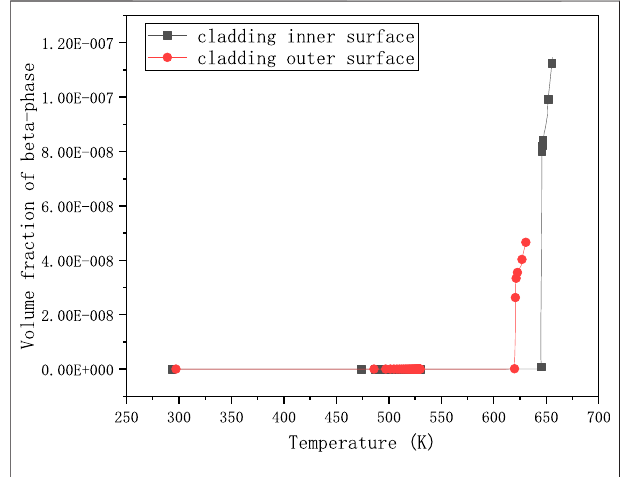
FIGURE 2 | Volume fraction of β -phase changing with temperature for UO 2 and Zircaloy-4 under normal operating